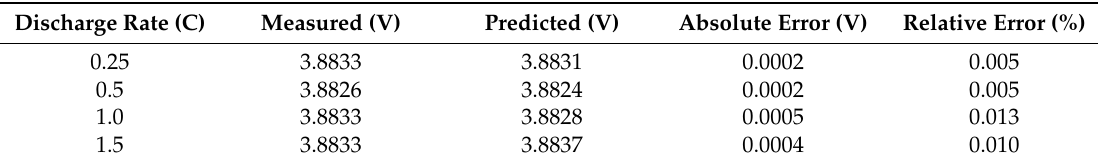
Figure 7. Validation results of LCO/MCMB battery discharged with different current rates: ( a ) 1.0 C and ( b ) 1.5 C. The SOC was 70% and the temperature was 35 °C. Table 5. Details of the validation results of LCO/MCMB battery with different discharge rates.